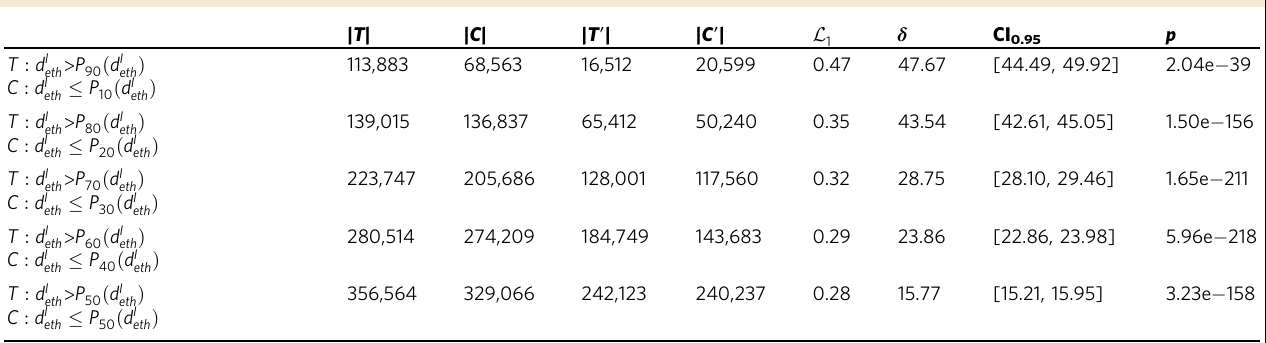
Table 3 Coarsened exact matching of individual ethnic